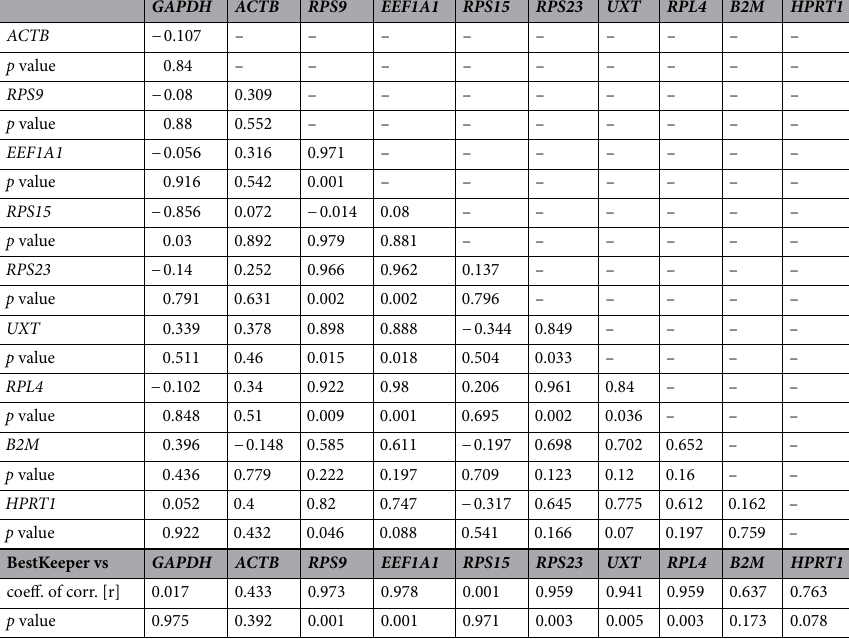
Table 5. Analysis of repeated pair-wise correlation amongst genes in LAC with BestKeeper index.